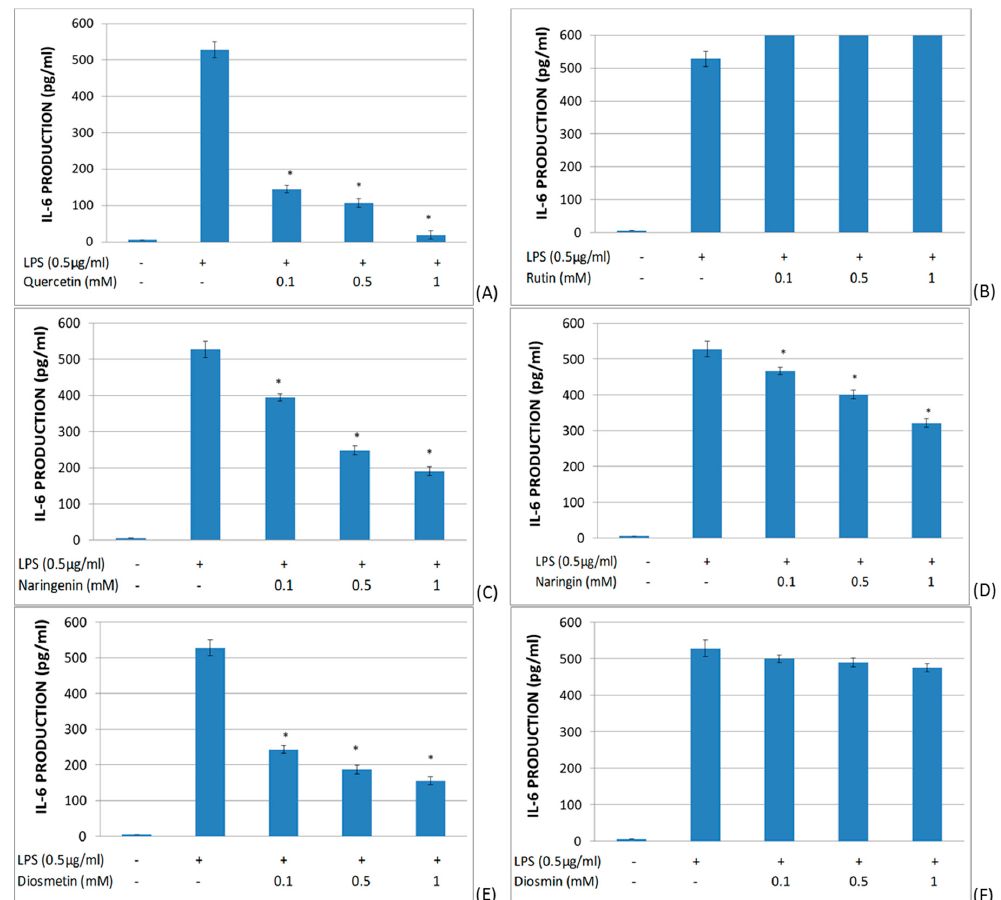
Figure 4. Effects of different flavonoids on the production of IL-6 in LPS-stimulated (0.5 μ g/mL) whole blood after 6 h of culture. The different panels show the results of the effects of quercetin ( A ), rutin ( B ), naringenin ( C ), naringin ( D ), diosmetin ( E ), and diosmin ( F ). All data are expressed as the mean (top segment of the rectangles) ± SEM (vertical segment) of thirty independent experiments. * p < 0.05: significantly different when compared to the LPS control. The effects of quercetin, rutin, naringenin, naringin, diosmetin, and diosmin on IL-6 secretion in LPS-stimulated whole blood were studied (Figure 4). It was found that quercetin, naringenin, diosmetin, and naringin significantly reduced IL-6 production in a dose-dependent manner. On the other hand, rutin and diosmin did not significantly modify the IL-6 production in LPS-stimulated whole blood.